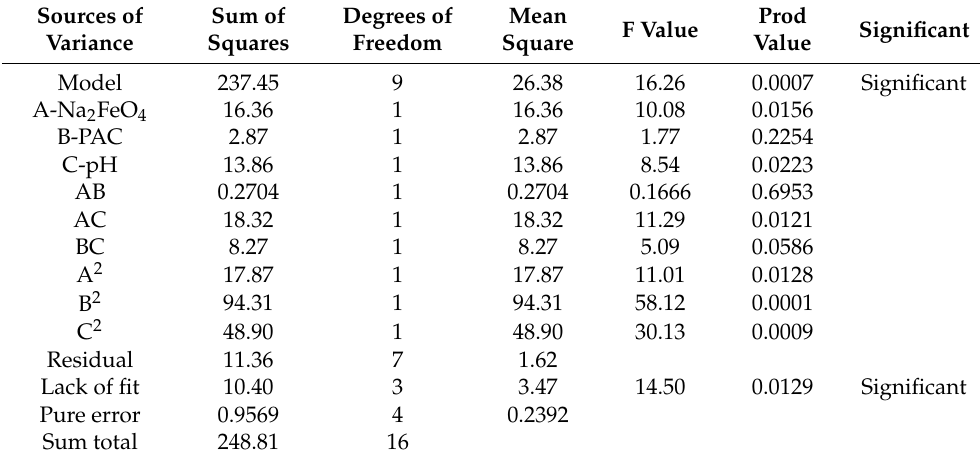
Table 3. Results of variance